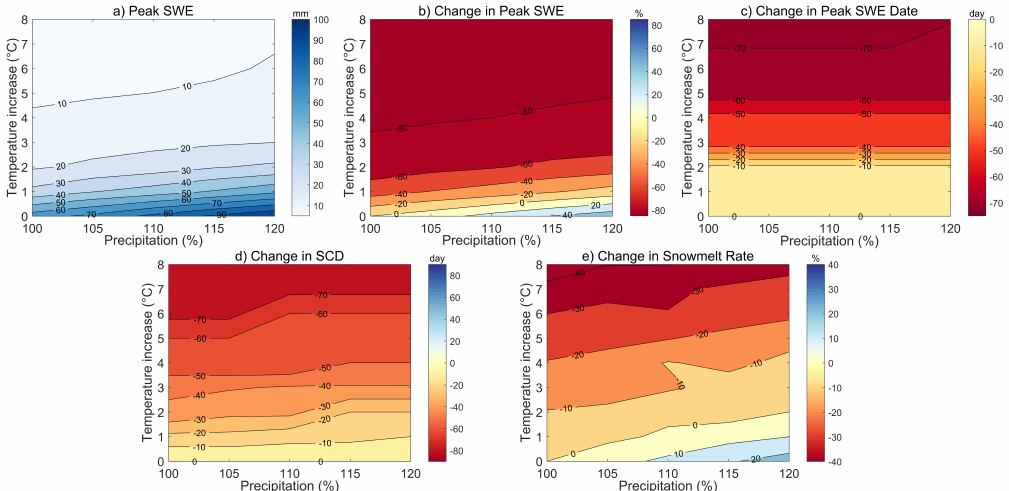
Figure 9. Climate sensitivity of snow metrics. ( a ) Annual peak SWE; ( b ) relative change in annual peak SWE; ( c ) change in annual peak SWE date—negative values represent a shift towards earlier dates; ( d ) change in snow cover duration (SCD); ( e ) relative change in the snowmelt